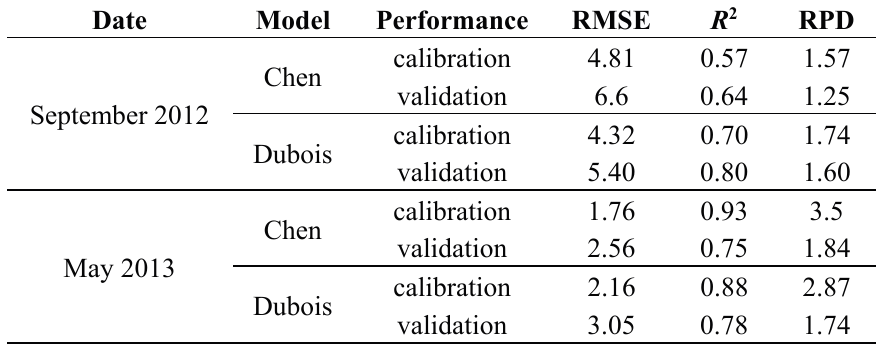
Figure 4. Comparison between measured and retrieved soil moisture using the two developed models for calibration: ( a ) Chen model in September 2012 ( R 2 = 0.57, RMSE = 4.81); ( b ) Chen model in May 2013 ( R 2 = 0.91, RMSE = 1.8); ( c ) Dubois model in September 2012 ( R 2 = 0.7, RMSE = 4.3); and ( d ) Dubois model in May 2013 ( R 2 = 0.88, RMSE = 2.1). Table 5. Summary of validation results of the two models for soil moisture